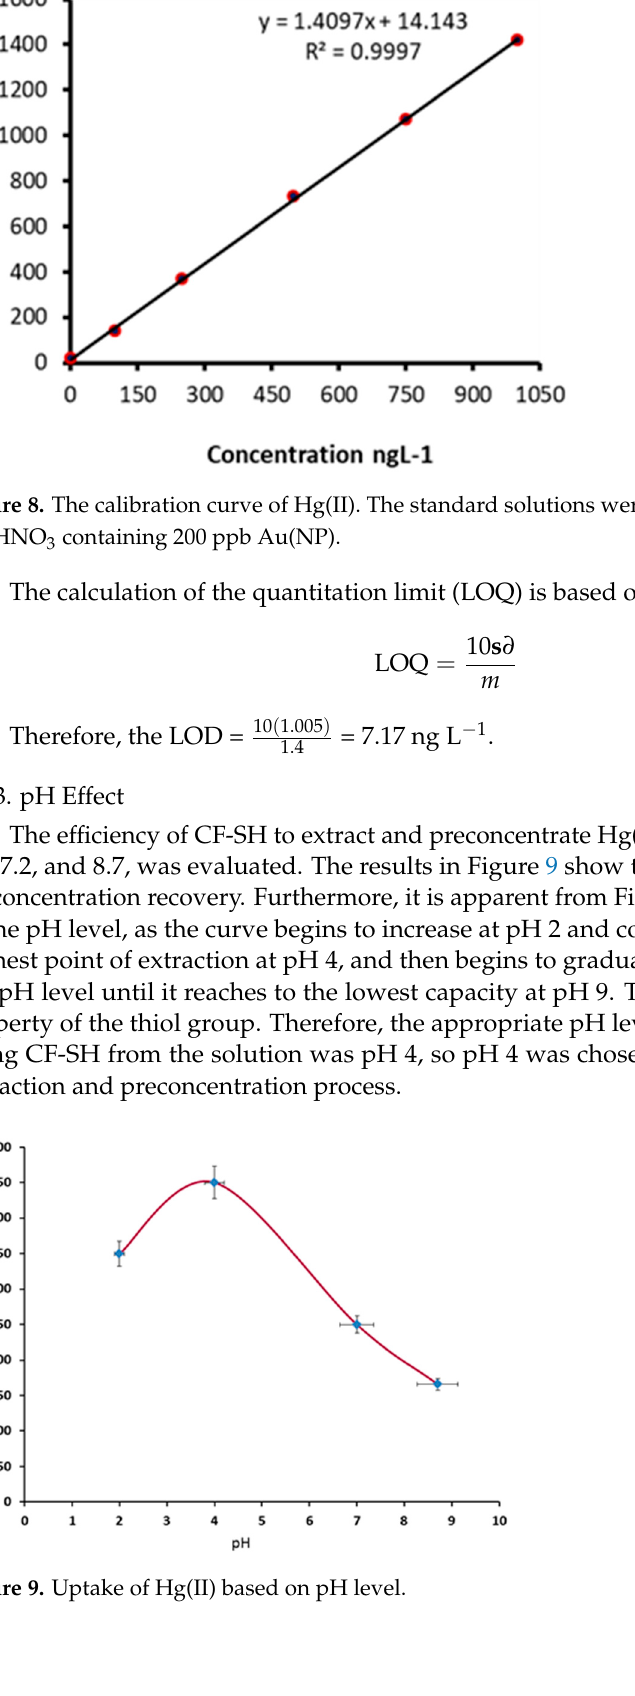
Figure 10. Uptake of Hg(II) based on equilibrium time. 3.2.5. Capacity of CF The maximum mercury uptake by CFs was estimated using Equation (3). Three batches of unmodified CF, CF-OH, and after functionalisation with thiol groups. Table 3 reveals that all CFs have the ability to uptake mercury. However, CF-SH showed a supe- rior uptake, five times better than CF, which can be attributed to the high surface area of the CF (1800 m 2 g − 1 ) and the functionalisation of CF with the thiol groups, which increase the ability of the CF to attract mercury ions from the solution. 𝑪𝒂𝒑𝒂𝒄𝒊𝒕𝒚(cid:4666)𝑪𝒕 𝒎𝒈/𝒈(cid:4667) = (cid:3436) 𝑯𝒈 𝒖𝒑𝒕𝒂𝒌𝒆 𝒃𝒚 𝑪𝑭 𝒊𝒏 𝒎𝒈 ∗ (cid:4666)𝟏𝟎𝟎𝟎(cid:4667) 𝒘𝒆𝒊𝒈𝒉𝒕 𝒐𝒇 𝒅𝒓𝒚 𝑪𝑭 𝒖𝒕𝒊𝒍𝒊𝒛𝒆𝒅 𝒊𝒏 𝒎𝒈(cid:4667)(cid:3440)